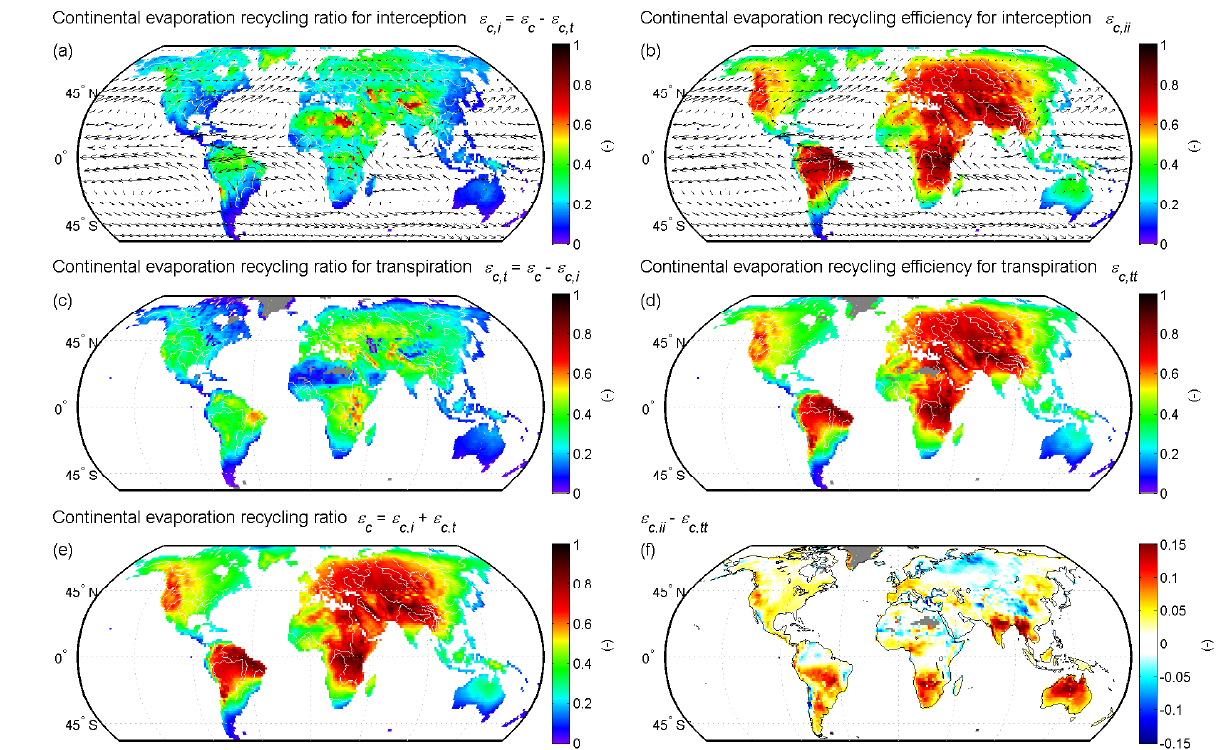
Figure 3. Continental evaporation recycling (1999–2008). (a) Continental evaporation recycling ratio for interception ε c,i , (b) continental evaporation recycling efficiency for interception ε c,ii , (c) continental evaporation recycling ratio for transpiration ε c,t , (d) continental evapo- ration recycling efficiency for transpiration ε c,tt , (e) continental evaporation recycling ratio ε c , and (f) ε c,ii − ε c,tt . Grey values on land